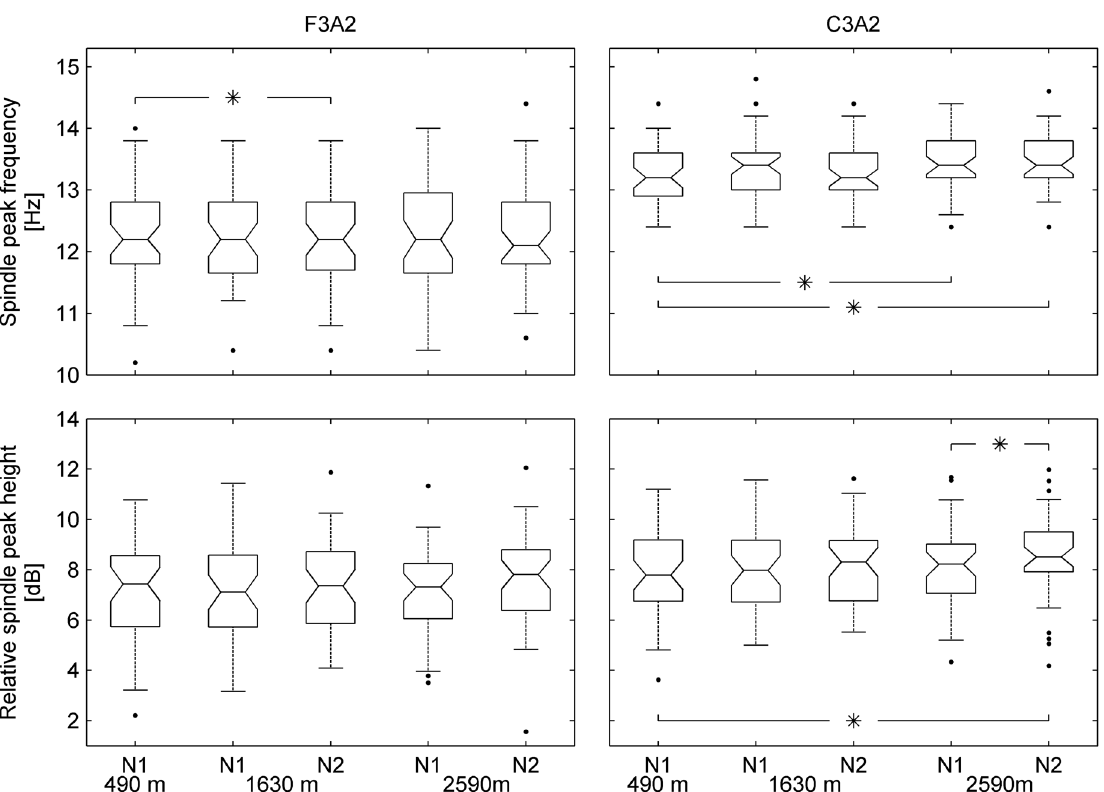
Figure 3. Sleep spindle characteristics. Spindle peak frequency: Average frequency of spindle peak in non-REM sleep EEG spectra. Relative spindle peak height: Peak height minus background activity at location of the peak. Data were derived from visually identified spindle peaks (n=44; see Gottselig et al. [20]). The box plots show the lower quartile, median and upper quartile values. Whiskers include the adjacent values in the data up to values within one time the interquartile range. Outliers, displayed with ‘.’ are values beyond the ends of the whiskers. The notch indicates the 95% confidence interval of the median. *p , 0.05: significant difference between baseline and altitude and between the first and second night (post-hoc paired t-test, whenever factor Altitude and/or Night were significant in the mixed model ANOVA with factors Altitude , Night and Order ). N1, N2: night 1 and 2 at higher altitude.